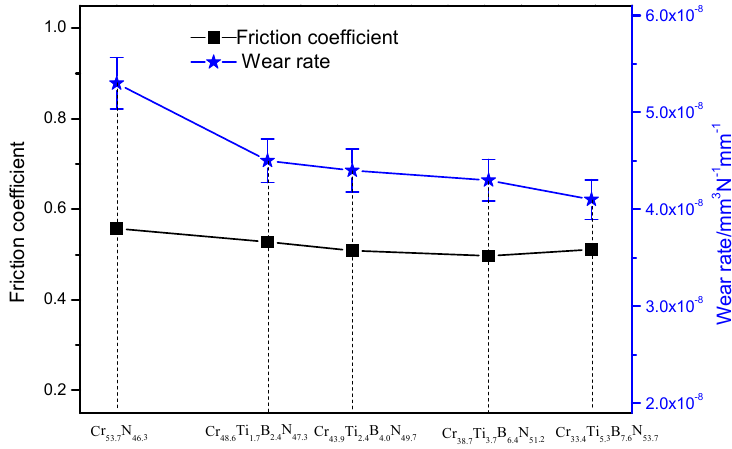
Figure 7. Friction coefficient and wear rate of Cr ‐ Ti ‐ B ‐ N films at room temperature. The wear track morphologies of Cr ‐ Ti ‐ B ‐ N films with different Ti and B contents are shown in